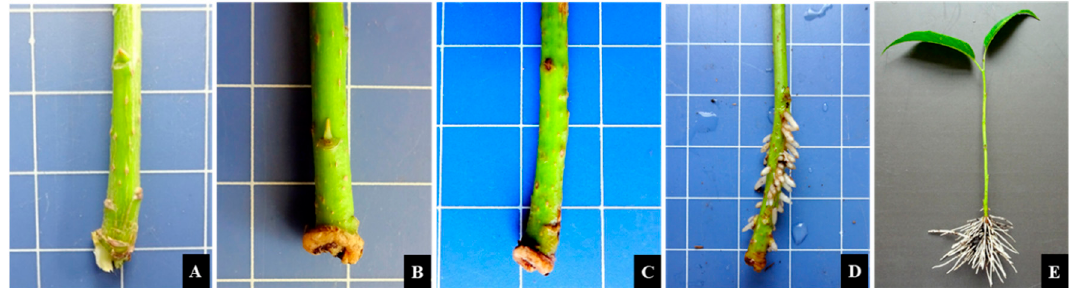
Figure 1. Morphological changes of E. ulmoides cuttings in the rooting process. ( A – E ) The rooting situation of cutting on the 0th, 12th 22nd, 32nd and 46th day of E. ulmoides .